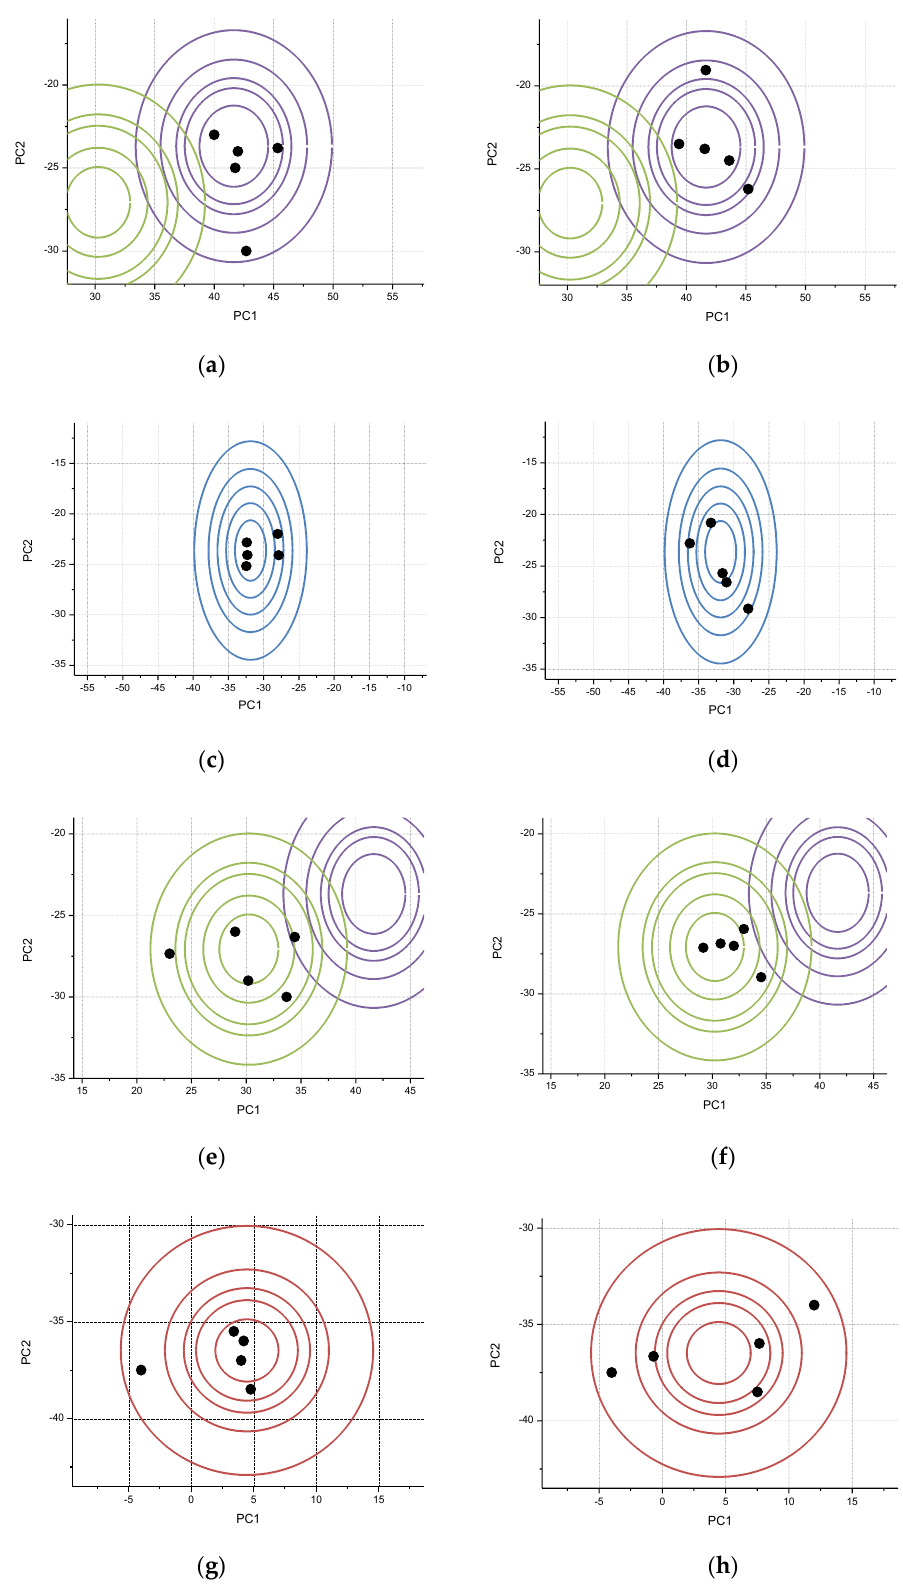
Figure 6. Cloud drop test of 8 groups of liquor data: ( a ) jiang-flavor style-1; ( b ) jiang-flavor style-2; ( c ) feng-flavor style-1; ( d ) feng-flavor style-2; ( e ) nong-flavor style-1; ( f ) nong-flavor style-2; ( g ) mild-flavor style-1; ( h ) mild-flavor